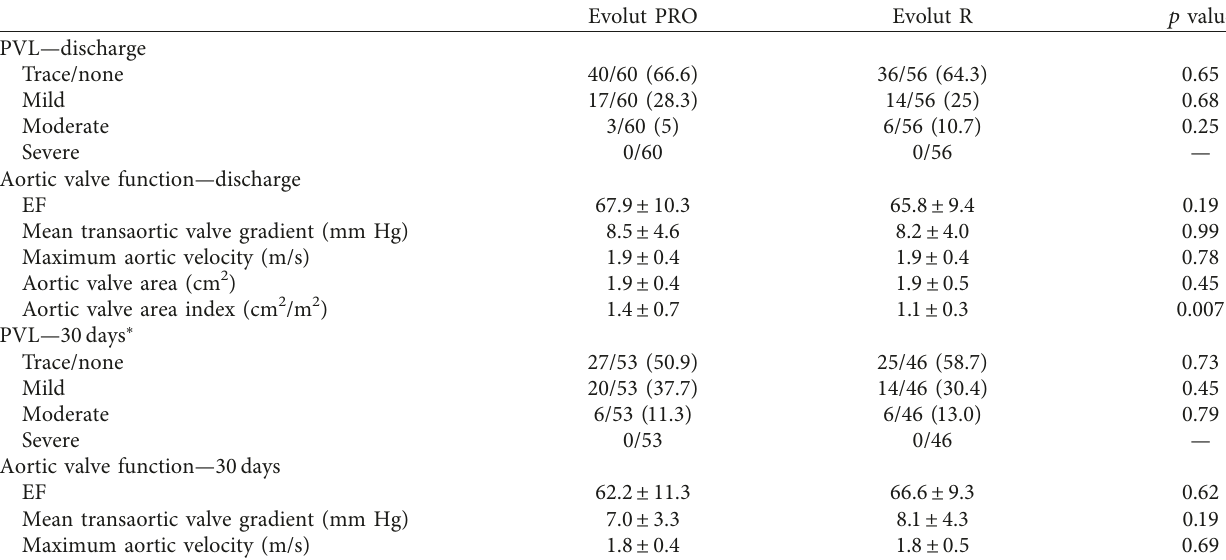
Table 4: Discharge and 30-day echocardiogram findings.